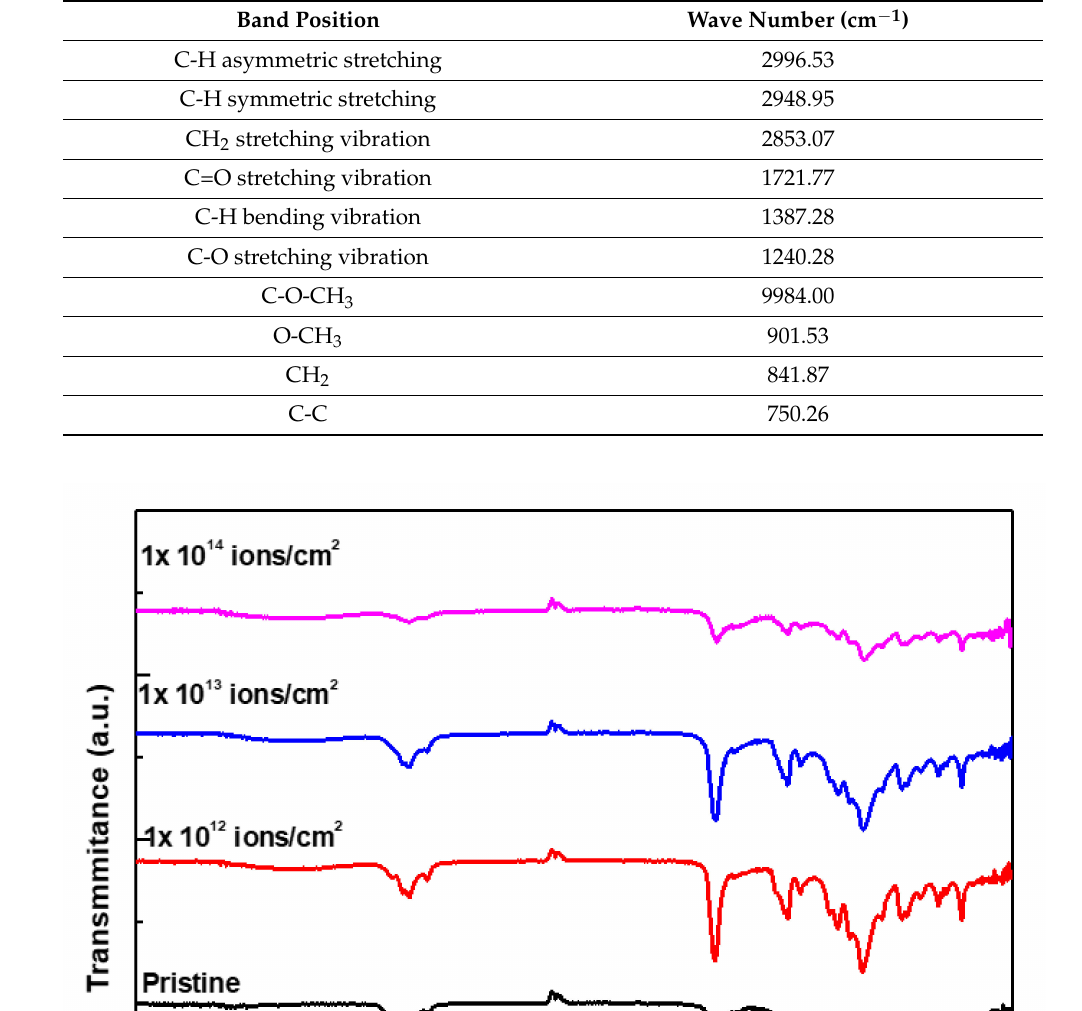
Table 2. Position of different bands of the FTIR spectra for pristine and implanted PMMA.